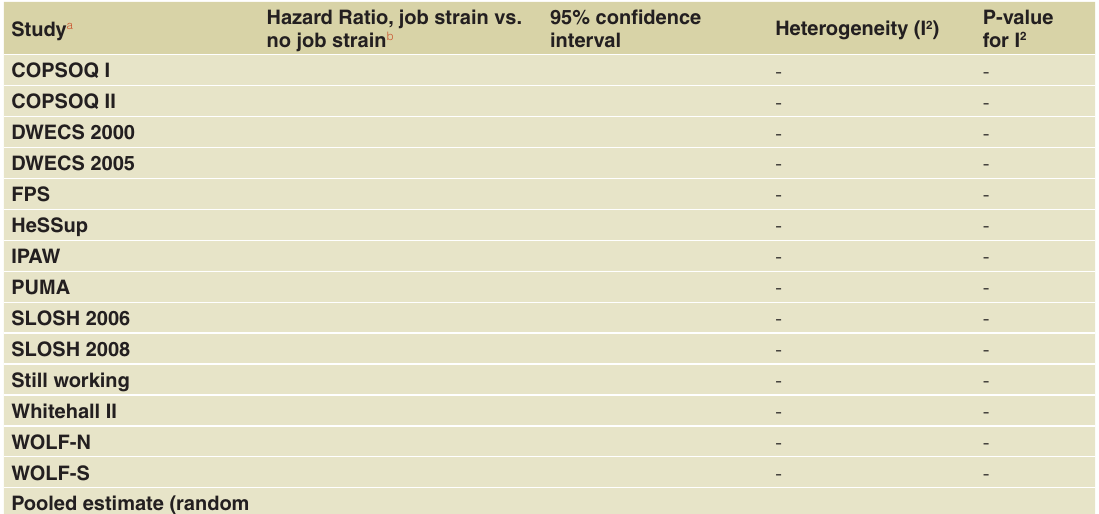
Table 3. Ghost table for main results. Study a